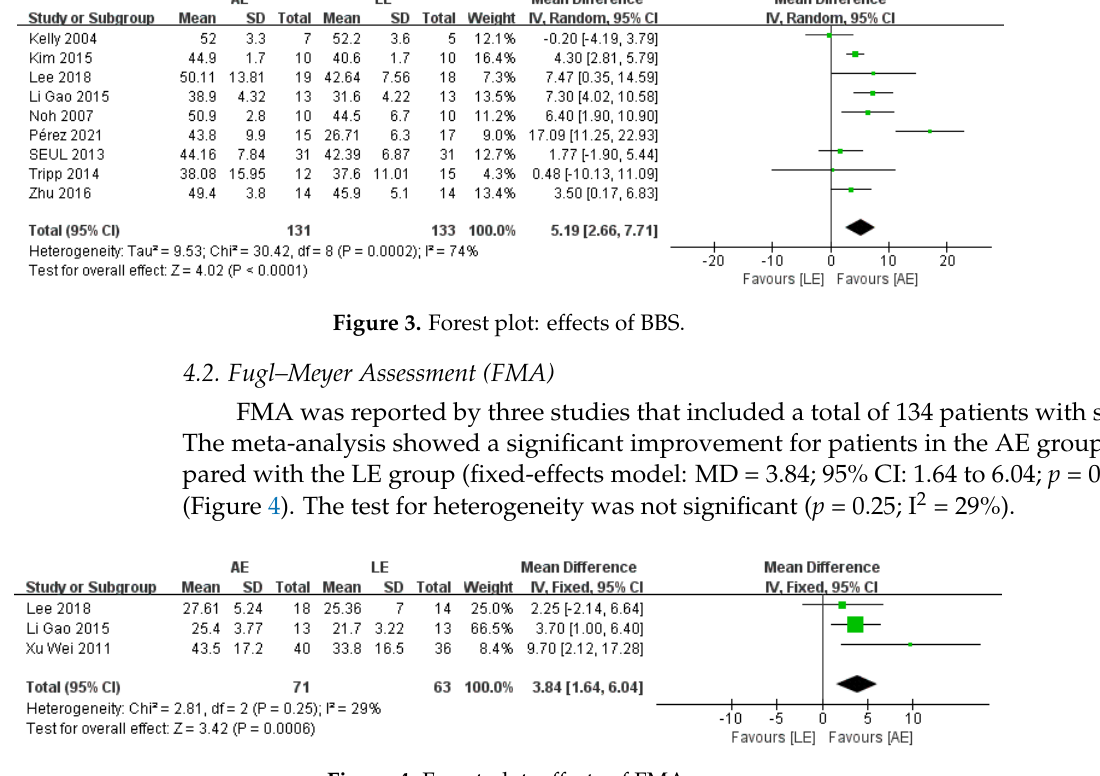
Figure 4. Forest plot: effects of FMA.